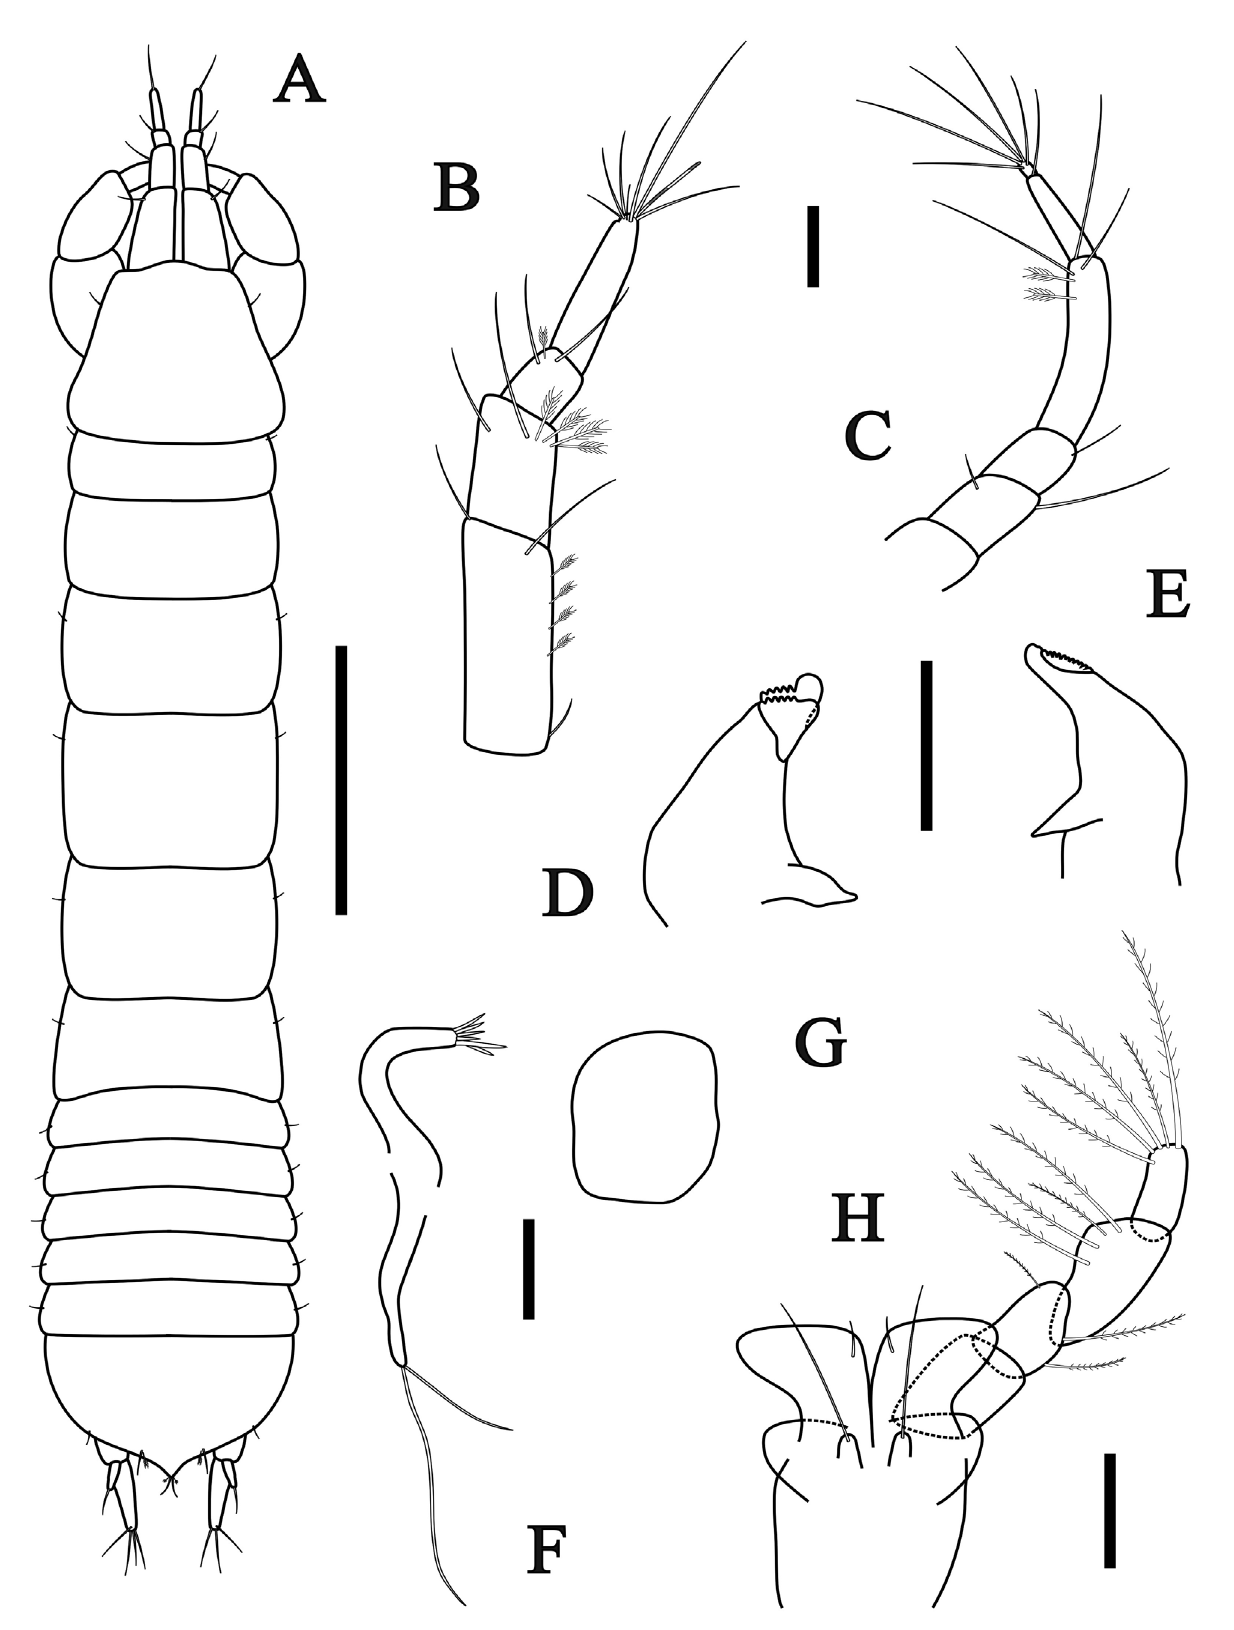
Figure 1. Tanaopsis bamberi sp. nov., female paratype, length 4.5 mm, MNRJ 23402. A, dorsal view; B, antennule; C, antenna; D, left mandible; E, right mandible; F, maxillule; G, maxilla; H, maxilliped. Scale bars: A = 1 mm; B-H = 0.1